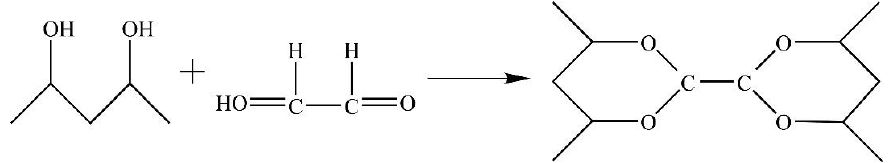
Figure 6. Diagram of the cross-linking reaction between glyoxal and PVA.